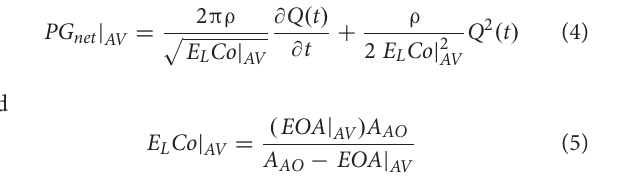
both pre and post interventional status (see Figure 1 for Schematic diagrams; Figure 2 for Flow chart; Table 1 for Cardiovascular